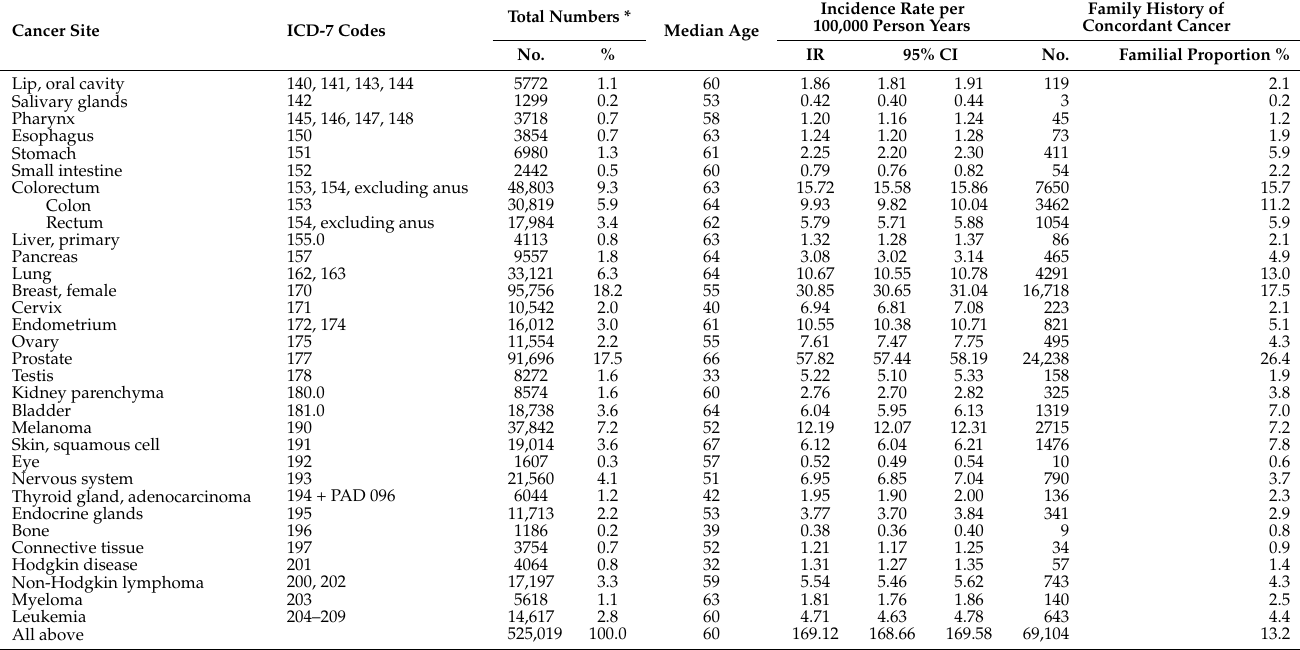
prostate cancer 17.5% (57.82/100,000) of all patients. The median age at diagnosis for these second generation patients was 60 years, which is about 10 years lower than that for all cancers in the Swedish Cancer Registry. The median diagnostic age was highest for squamous cell skin (67 years) and prostate cancers (66 years) and lowest for Hodgkin disease (32 years) and testicular cancer (33 years). A total of 69,104 patients had concordant cancers, accounting for 13.2% of all cancers in the offspring generation. More than 1/3 of these were prostate cancers, for which the familial proportion of 26.4% was highest. This was followed by breast (17.5%), colorectal (15.7%), and lung (13.0%) cancers. For rare cancers, such as salivary gland and bone cancers the proportions were 0.2% and 0.8%, respectively. The number of all families was 449,545 and of these 53,132 (11.8%) had concordant cancers. Table 1. Number of cancers, median ages, incidence rates, and number of familial cancer in the 20 to 84 year old index population (N = 9,338,882) during 1958–2016. Cancer Site Lip, oral